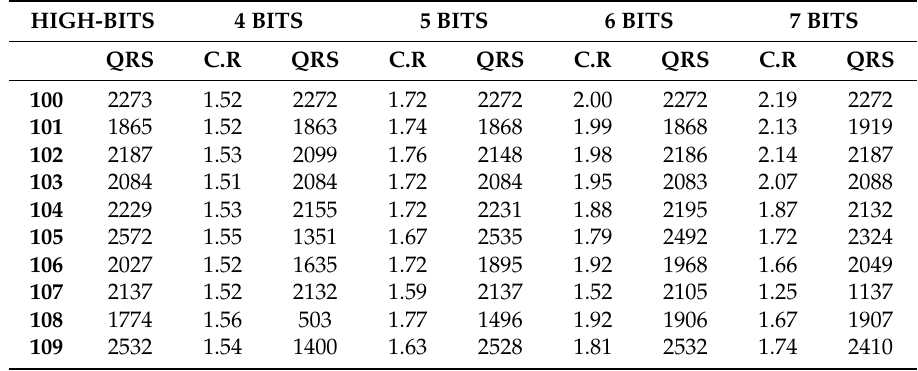
Table 3. Dynamic-block mode compression ratio (CR) and heartbeat detection rate.